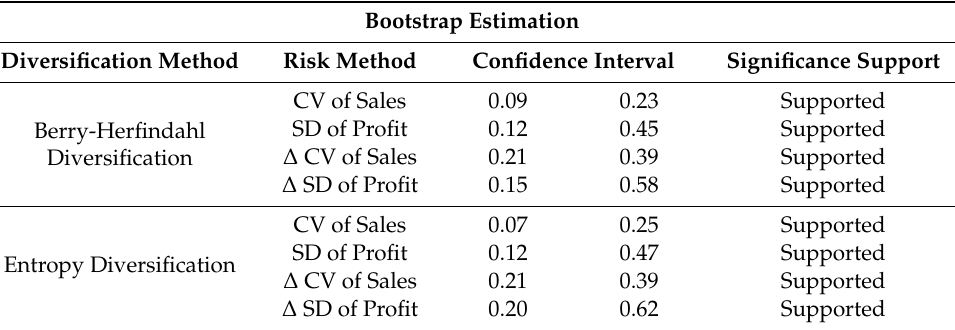
Table 8. t -test of the E ff ect Di ff erence of Diversification and